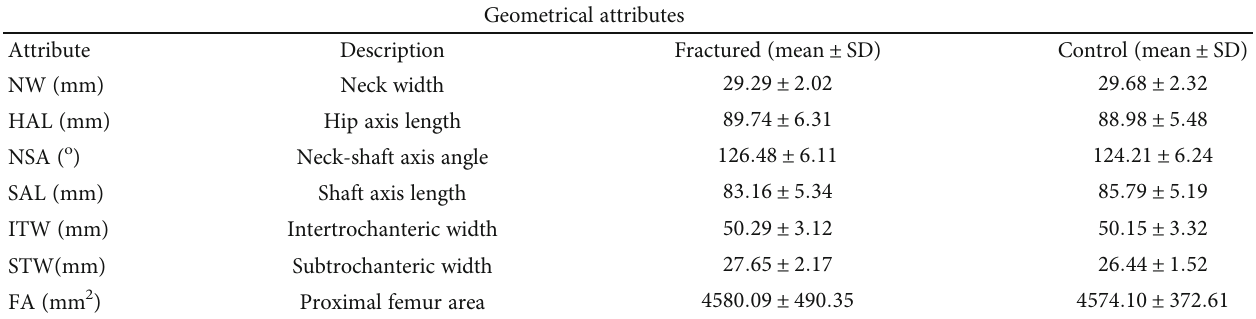
Table 2: Geometrical attributes.